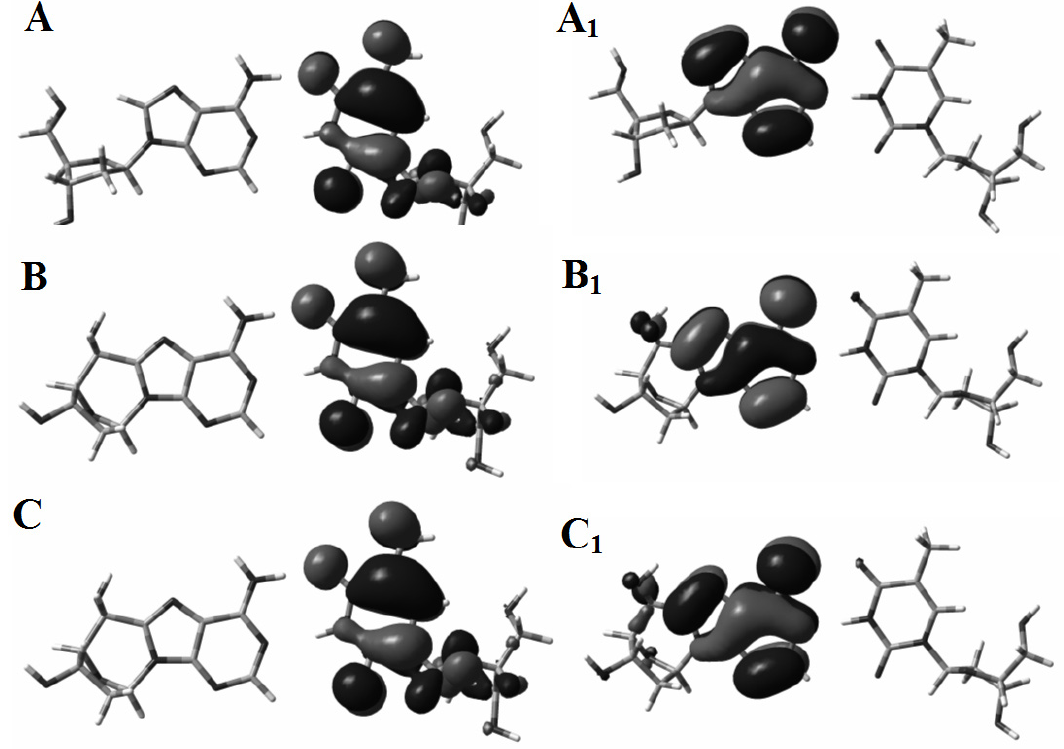
Figure 5. The visualization of high occupied molecular orbital (HOMO) distribution in the optimized cationic form of nucleoside pairs: A ) [dA::T]  , B ) [cdA(R)::T] + and C ) [cdA(S)::T] + and high occupied molecular orbital (HOMO) in the optimized neutral form of A cdA(R)::T and C 1 ) cdA(S)::T